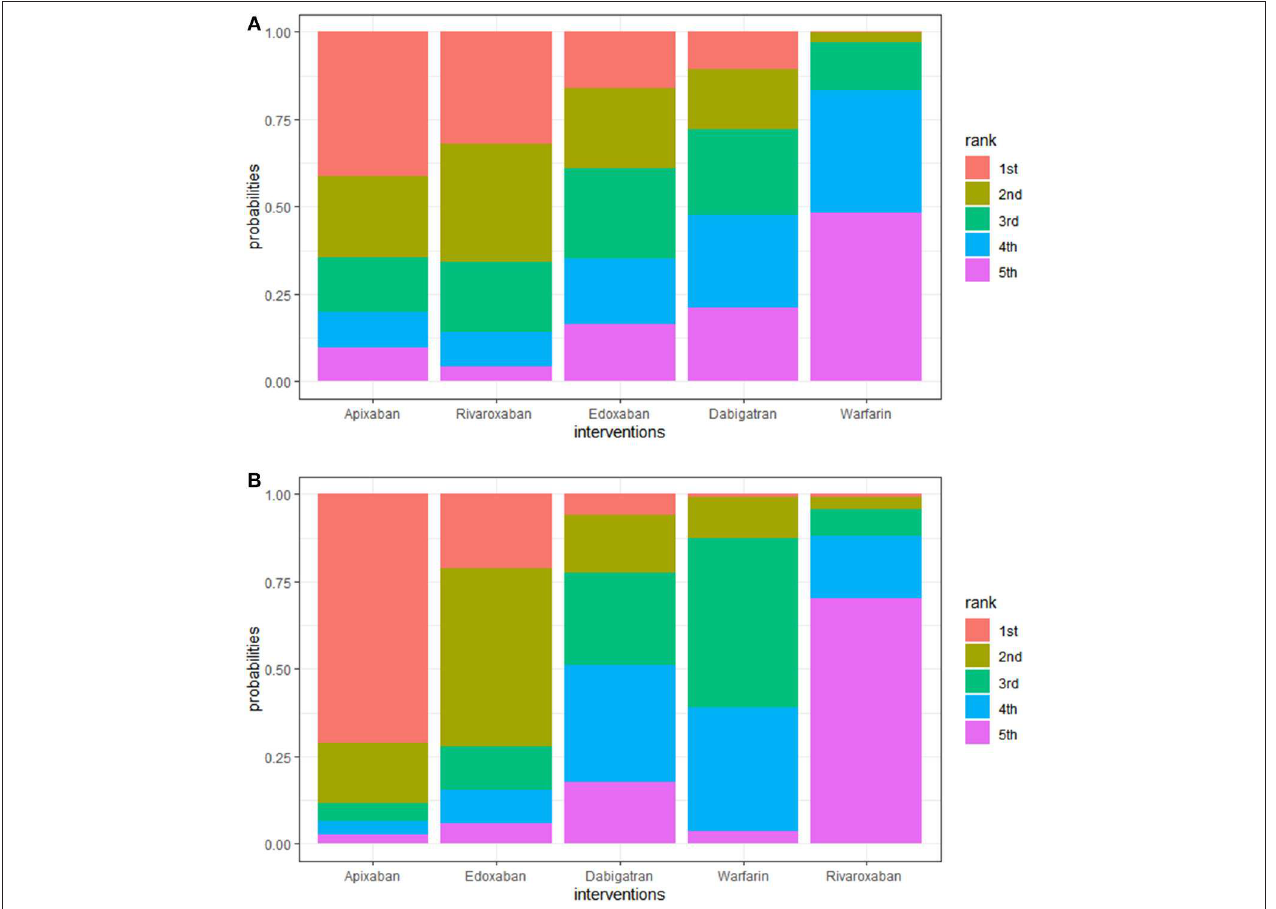
FIGURE 3 | (A) Rank plot of interventions in efficacy. A larger width of the red column indicated that the drug is more likely to be the best in efficacy. Interventions are ranged from best to worst. For example, the ranking suggests that warfarin posed the worst efficacy in elderly patients with AF, while apixaban posed the best. (B) Rank plot of interventions in safety. A larger width of the red column indicated that the drug is more likely to be the best in safety. Interventions are ranged from best to